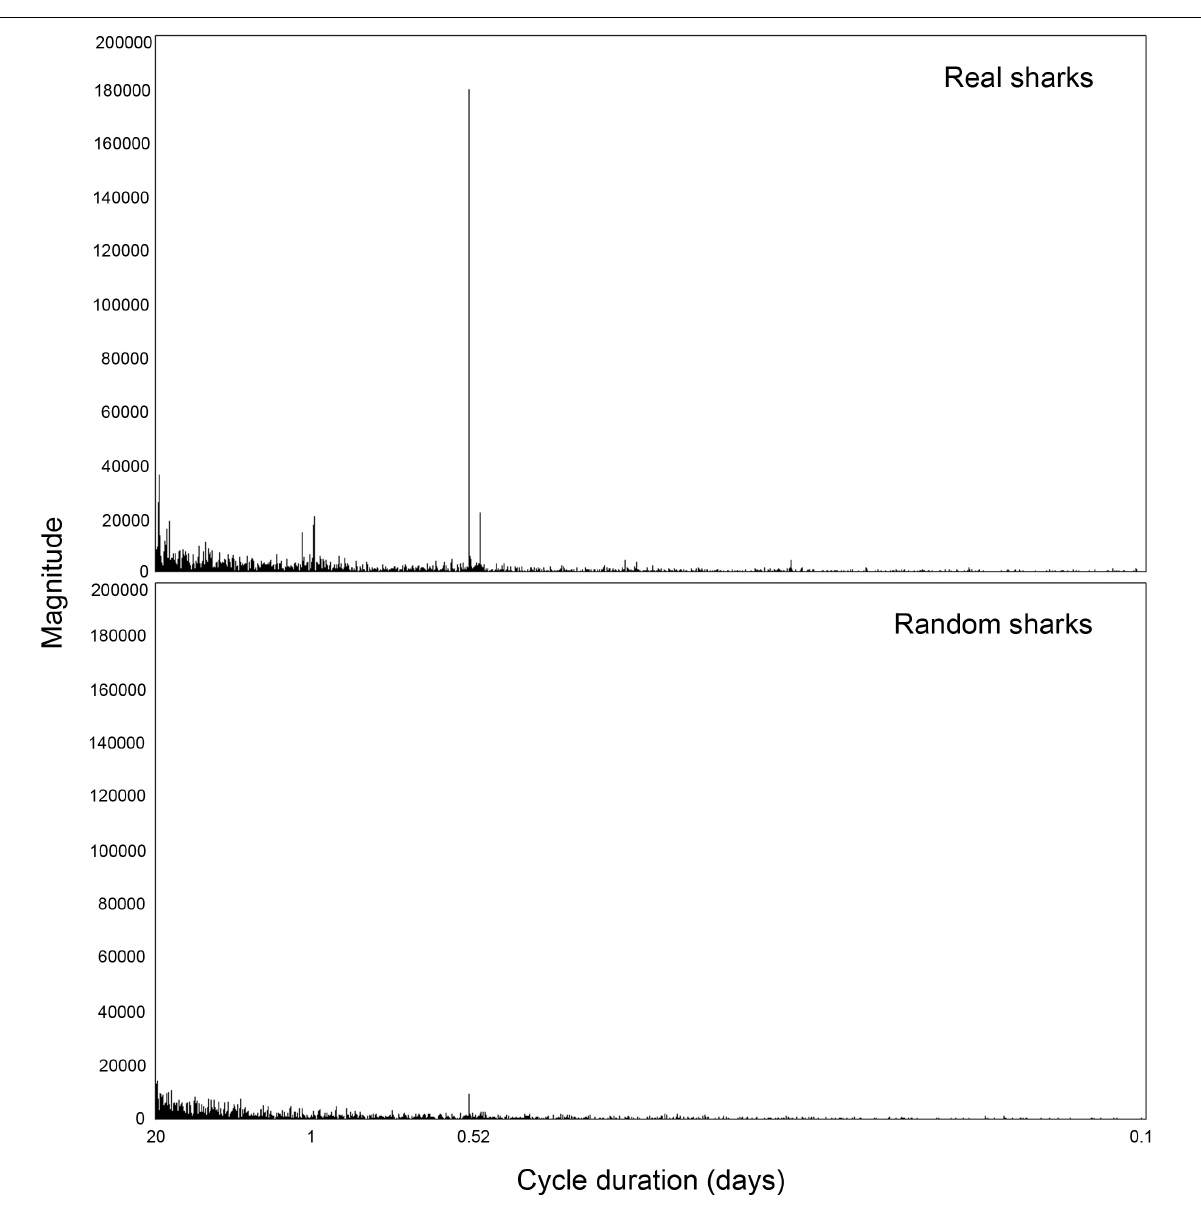
FIGURE 6 | Fast Fourier Transformation (FFT) analysis of peak frequency in overlap magnitude between blacktip reef sharks Carcharhinus melanopterus and sicklefin lemon sharks Negaprion acutidens , for real and random